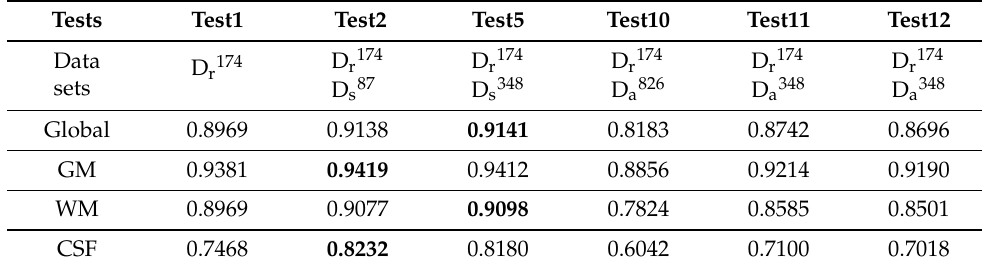
Table 5. Results for comparison between data augmentations techniques. The best results are in